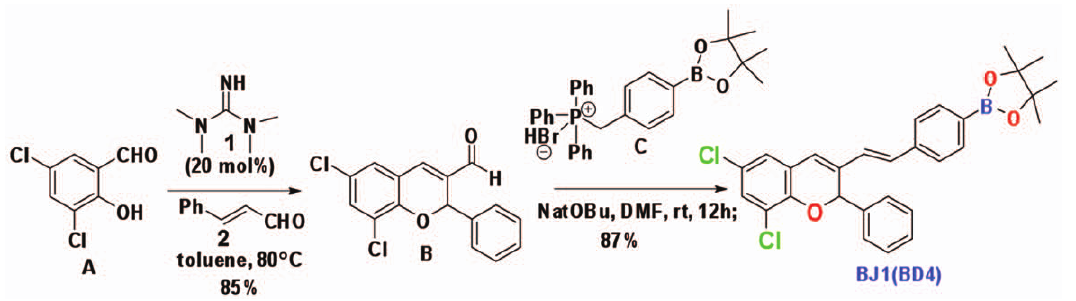
Figure 2. Reaction scheme to synthesize BD4. Compound B was synthesized from compound A by organocatalytic domino oxa-Michael/aldol reaction using organocatlyst 1. Compound B was further derivatized to compound BD4 by using Wittig reactions using Compound C as Wittig salt.